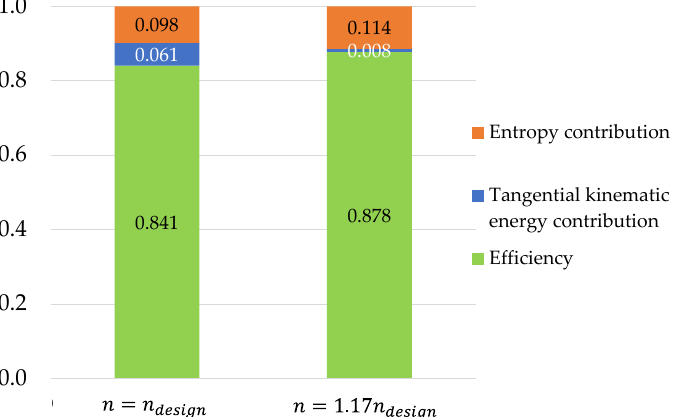
Figure 20. Comparison of main loss contributions and efficiency at Q = 1.17 Q design for two different rotational— H n = const .